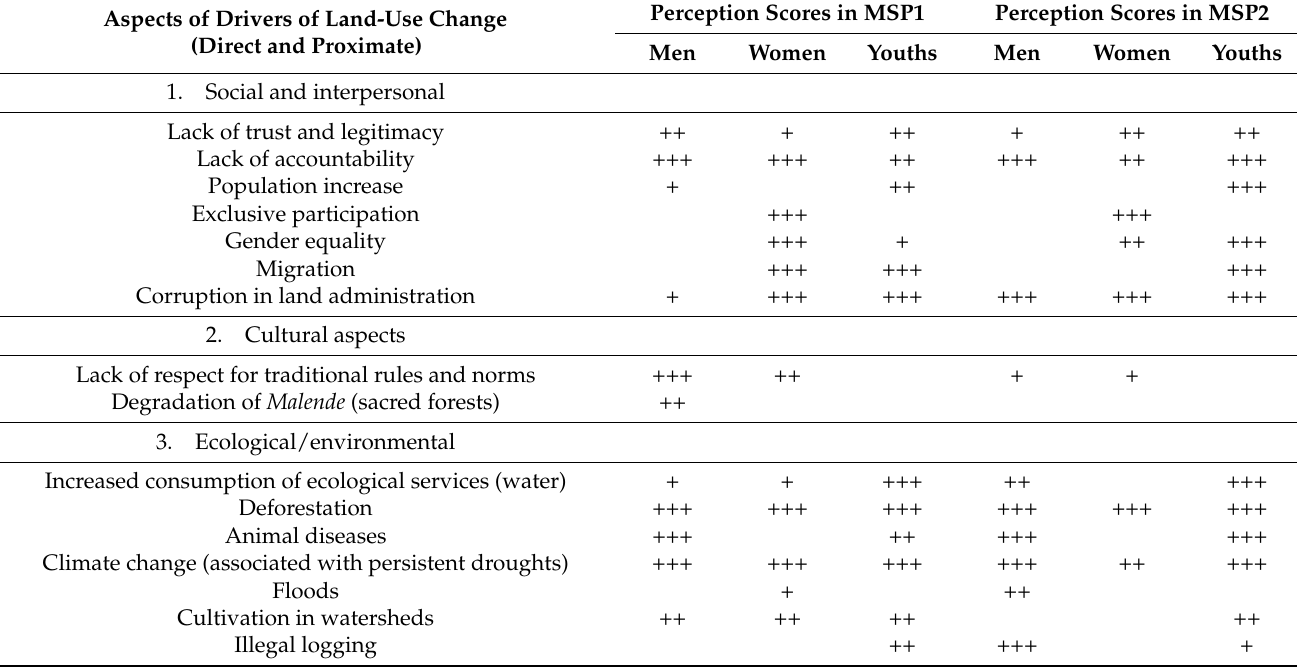
Table 5. Drivers of land-cover/land-use